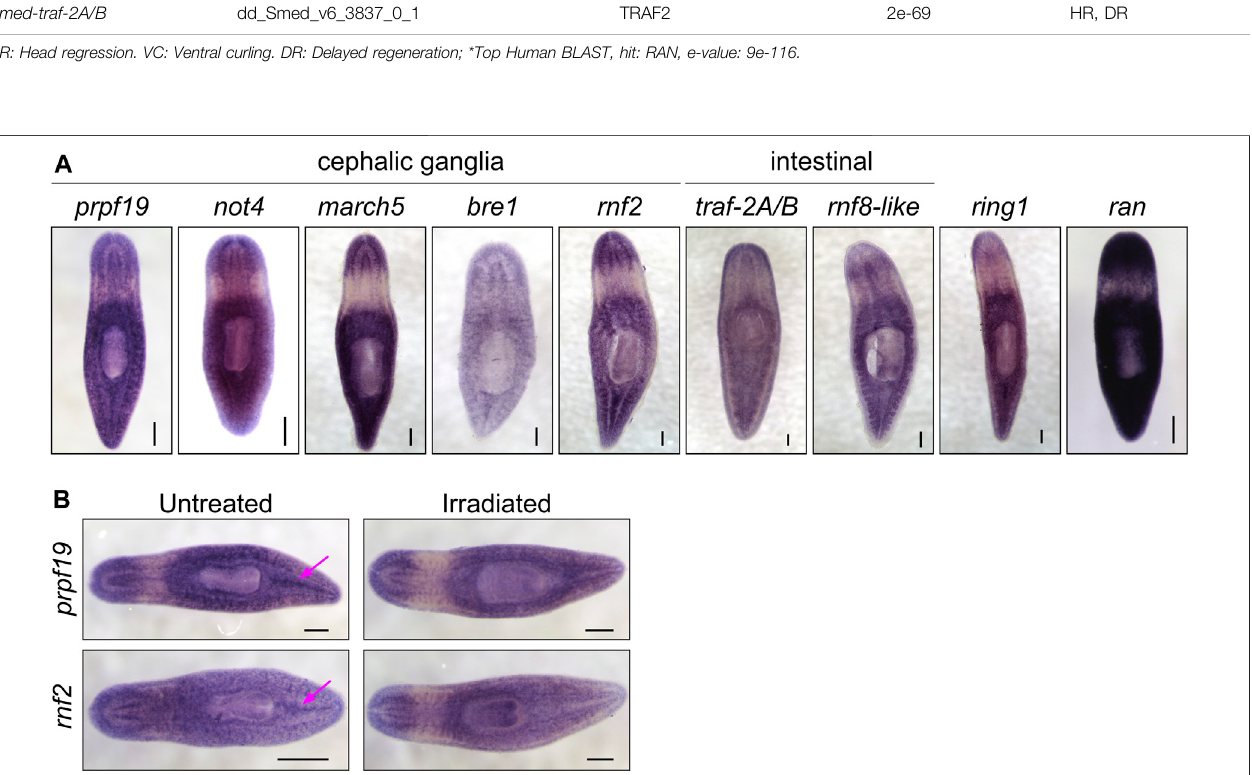
Frontiers in Cell and Developmental Biology |